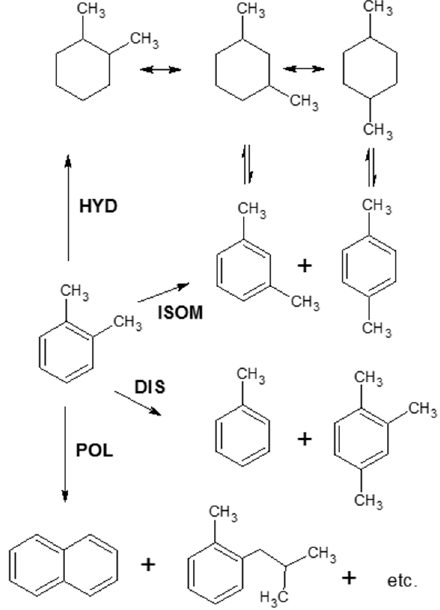
Figure 2. Reaction network of o-xylene hydrotreating (HDT).